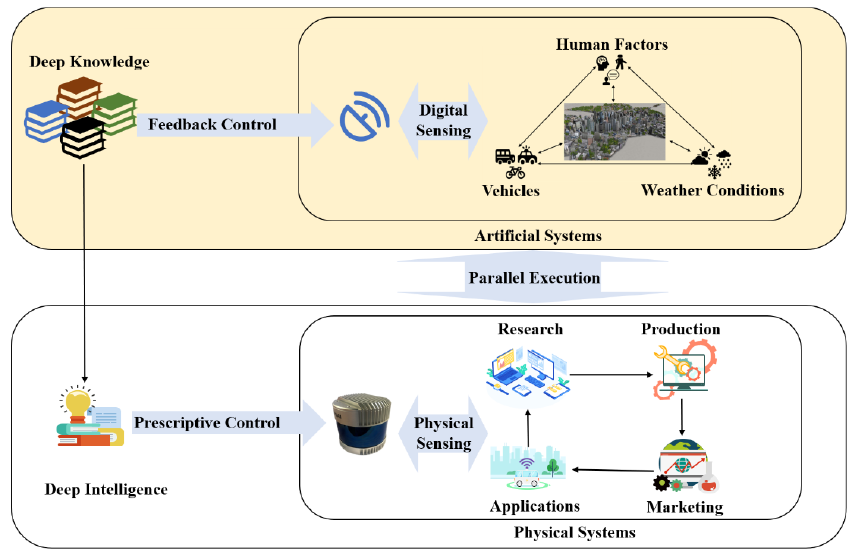
Figure 6. Prescriptive Radars: the framework and